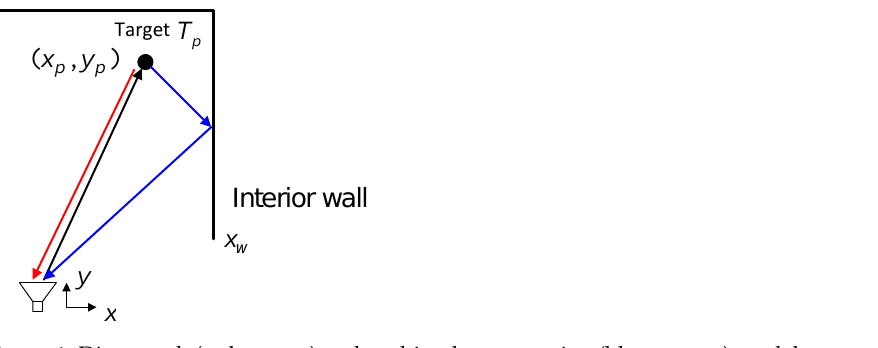
Figure 1. Direct path (red arrows) and multipath propagation (blue arrows)